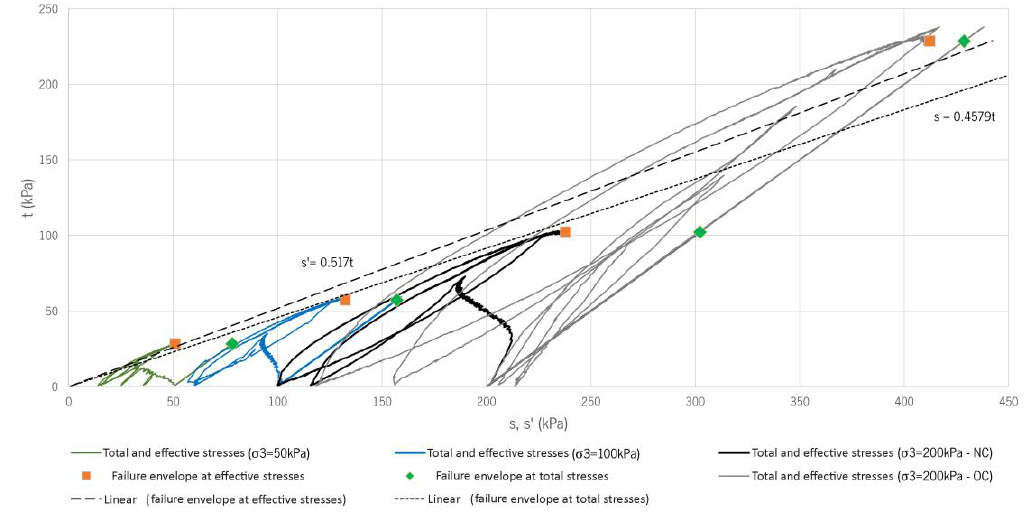
Figure 14. Mine tailing failure envelope.